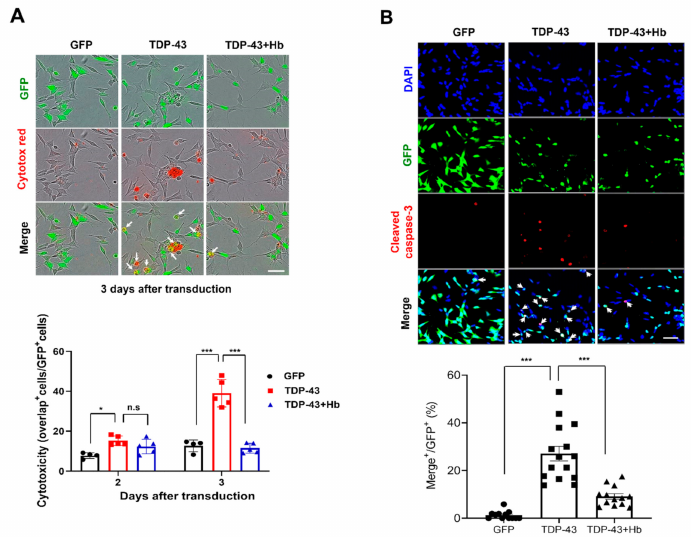
Figure 2. Hydroxocobalamin attenuates TDP-43-induced apoptosis in SH-SY5Y cells. ( A ) Hb (10 µ M) was administered the day after SH-SY5Y cells were infected with GFP or GFP-tagged human WT TDP-43 lentivirus. Cells were stained with Cytotox Red (dead) and imaged every 3 h using the IncuCyte live cell imaging system. Double-fluorescent (green and red) cells were counted and quantified. Data are presented as the means ± SD of three independent experiments. * p < 0.05, *** p < 0.001, and n.s., not significant (one-way ANOVA with Tukey’s multiple comparison test). Scale bar, 50 µ m. ( B ) SH-SY5Y cells were infected with a lentivirus encoding GFP or GFP-tagged human WT TDP-43 and cultured for 2 days, followed by treatment with Hb (10 µ M) for 24 h (the total virus infection period was 3 days). Immunocytochemistry was subsequently performed to detect cleaved caspase-3 (red) and DAPI (nuclear, blue). Arrowheads indicate colocalization of GFP-positive cells and cleaved caspase-3, and Hb inhibited TDP-43-induced apoptotic death in SH-SY5Y cells. The ratio of cleaved caspase-3-positive cells in the control (GFP) or GFP-tagged human WT TDP-43-expressing cells was quantified. Error bars represent the mean values ± SD of three independent